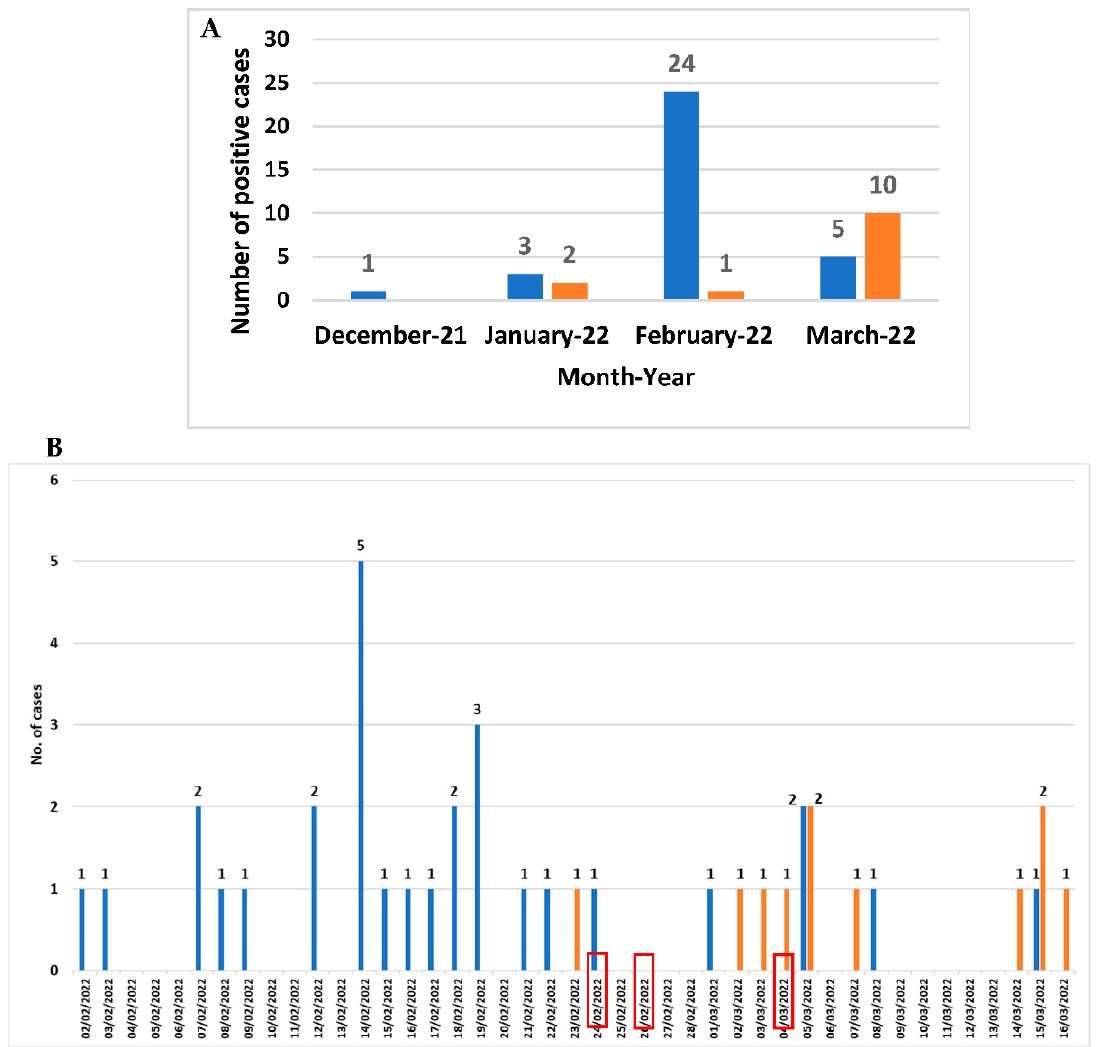
Figure 1. Month distribution from December 2021 to March 2022 ( A ) and daily distribution ( B ) from February to March 2022 of CDI cases in Long-term care Unit (blue) and in Internal Medicine ward (orange). The red boxes indicate the day when the three patients were transferred from the Long-term care Unit to the Internal Medicine ward.